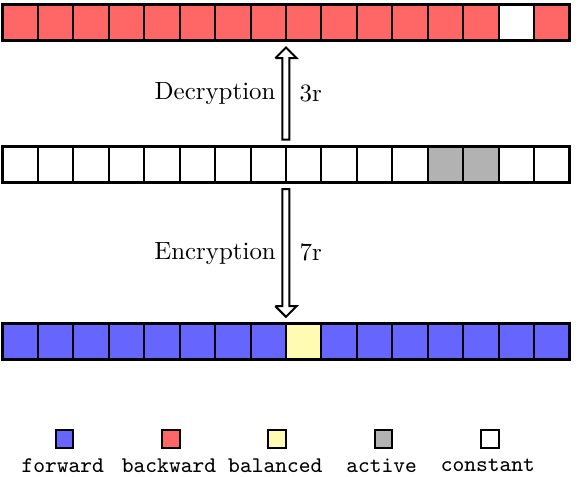
Figure 3: 10-Round integral distinguisher for